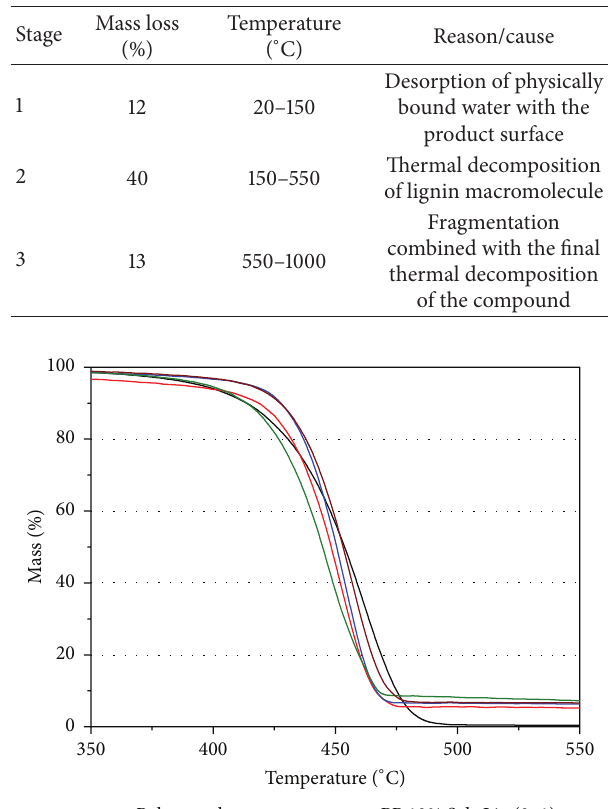
Table3:Theindividualstepsofthemasslossinrelationtoparticular temperatures for lignin.